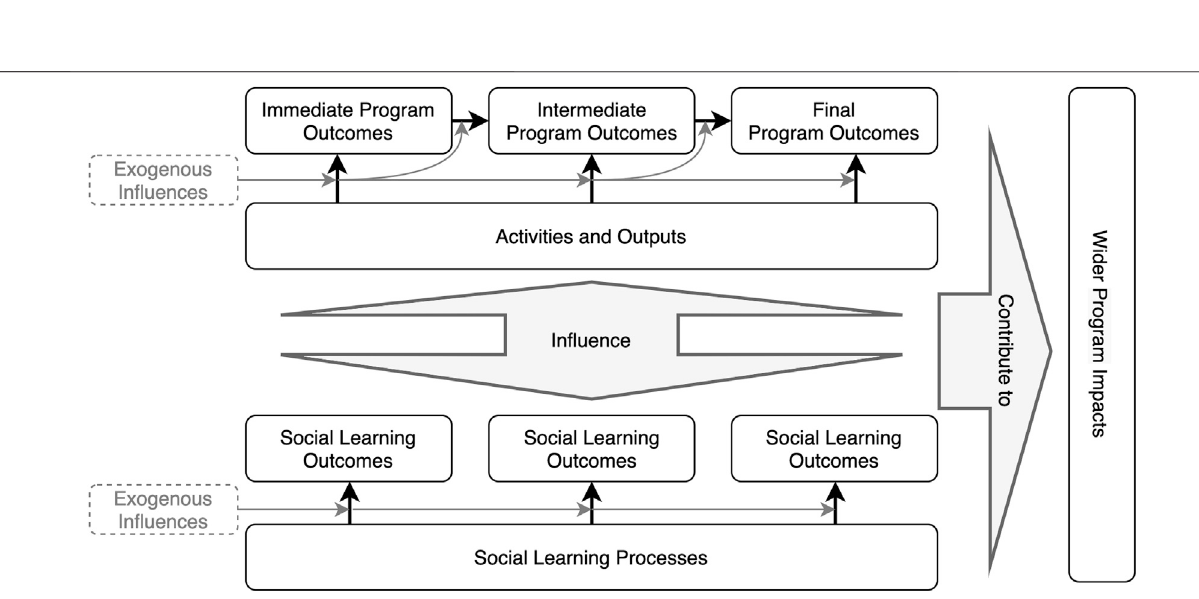
Frontiers in Sociology |